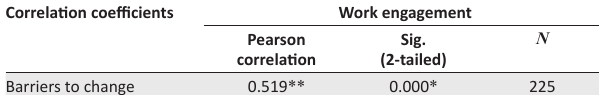
TABLE 3: Correlation coefficient between barriers to change and work engagement.